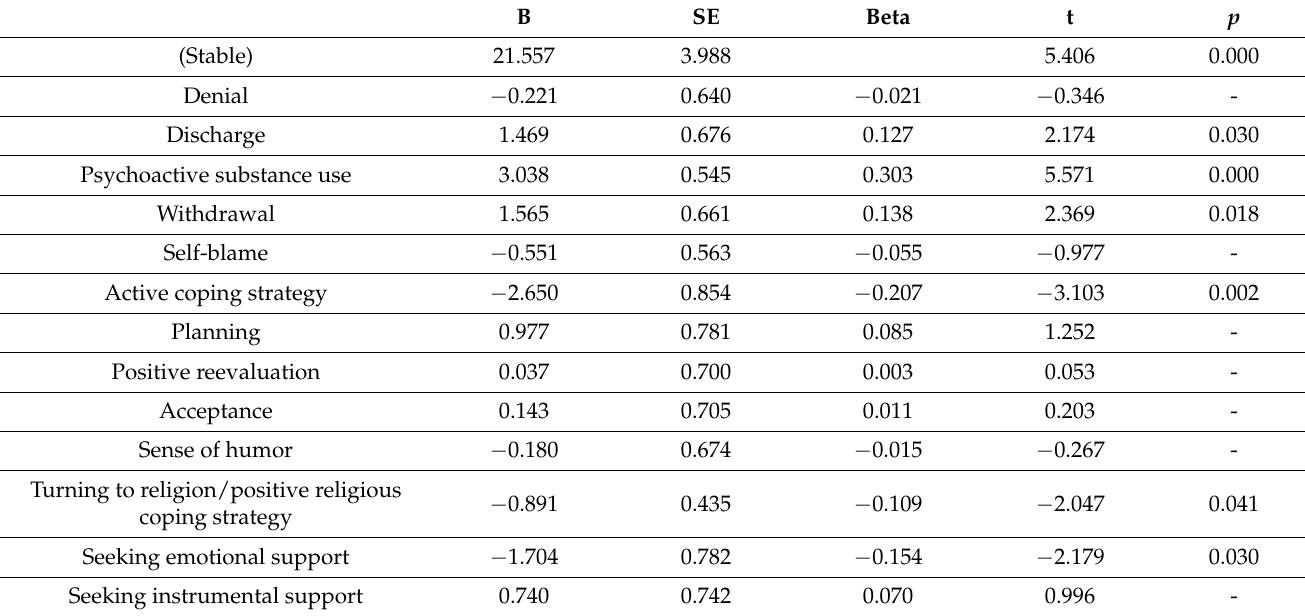
Table 8. Results of regression analysis to explain the general intensity of the aggression syndrome by passive and active stress coping strategies in a group of seniors ( n =